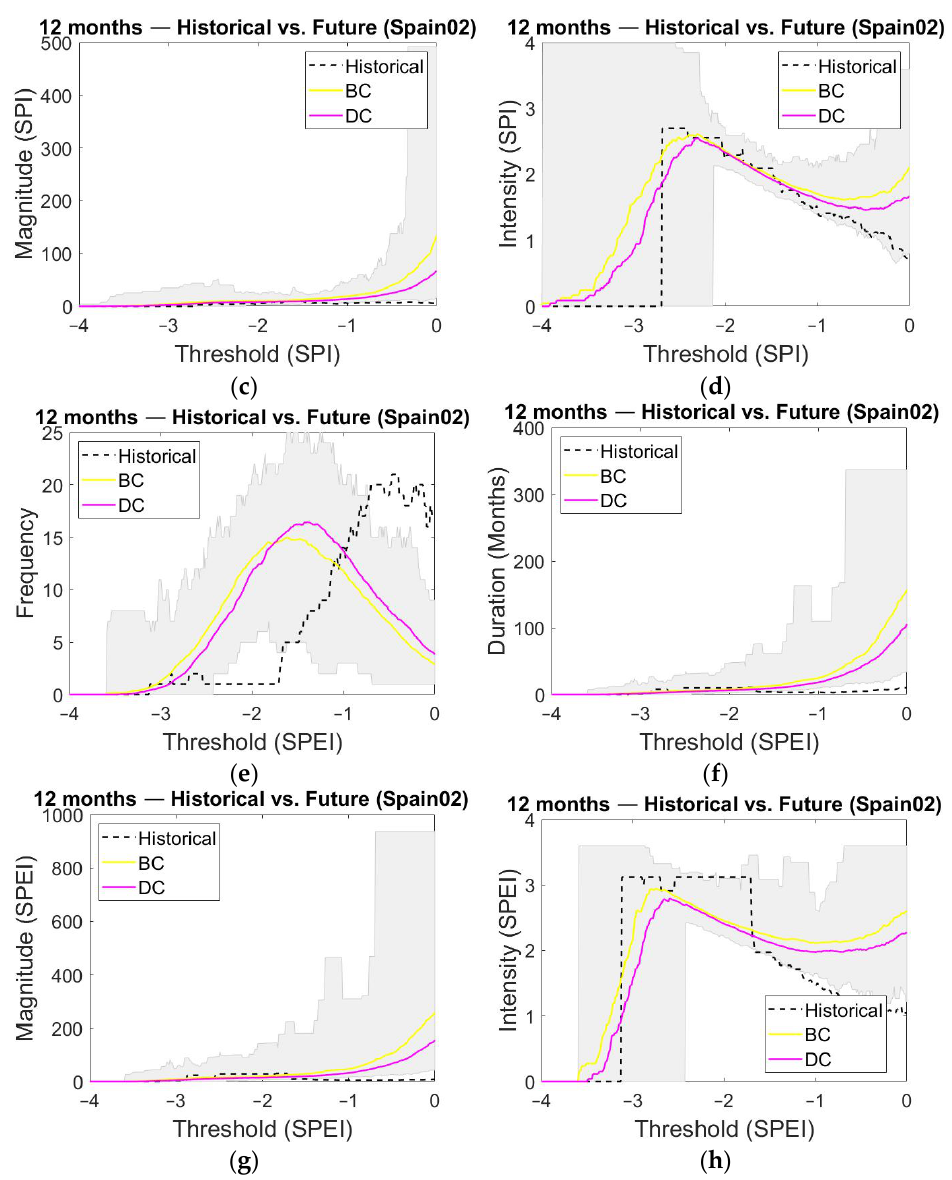
Figure A5. Historical and future meteorological drought ( a ) frequency; ( b ) mean duration; ( c ) mean magnitude; ( d ) mean intensity derived from SPI for the 12 months temporal-aggregation scale (Spain02 database). Historical and future meteorological drought ( e ) frequency; ( f ) mean duration; ( g ) mean magnitude; ( h ) mean intensity derived from SPEI for the 12 months temporal-aggregation scale (Spain02 database).